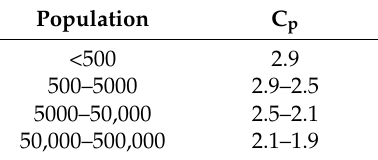
Table 2. Ratio of peak hourly flow to annual average flow